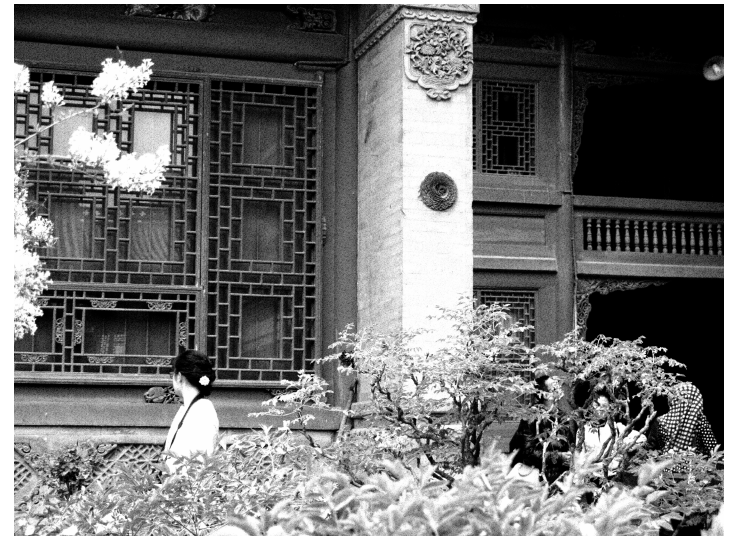
Figure 2. A Traditional Chinese Muslim Courtyard of Hezhou City (Zhou Chuanbin,